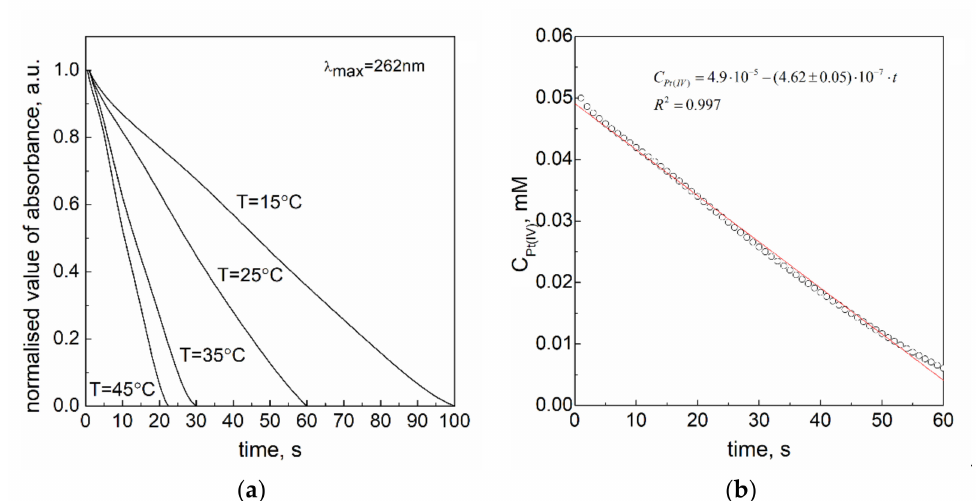
Figure 3. ( a ) The kinetic curves obtained at 262 nm for the reaction between platinum(IV) chloride complex ions and sodium borohydride in aqueous solution at different temperatures; ( b ) the sample of kinetic curve (change of Pt(IV) ions concentration in time of reaction reduction) at 25 ◦ C ( b ). Conditions: C 0,Pt(IV) = 0.05 mM, C 0,NaBH4 = 3.0 mM, pH = 12.9 ± 0.2.